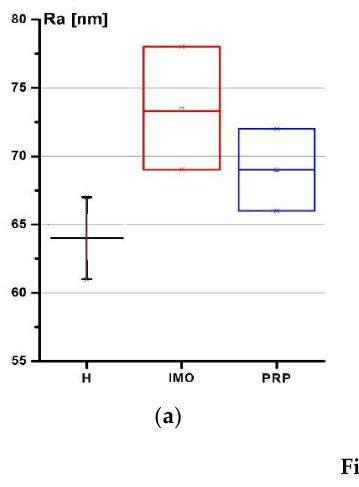
Figure 1. AFM images of rabbit cartilage surfaces 9 × 9 µm 2 : ( a ) group 1; ( b ) group 2; and ( c ) group 3. Damage and gaps were found on the cartilage tissue in group 2. Although the destruction sites were also found on cartilage in group 3, the size of the lesions decreased after PRP therapy. The roughness parameters of cartilage are presented in Figure 2.